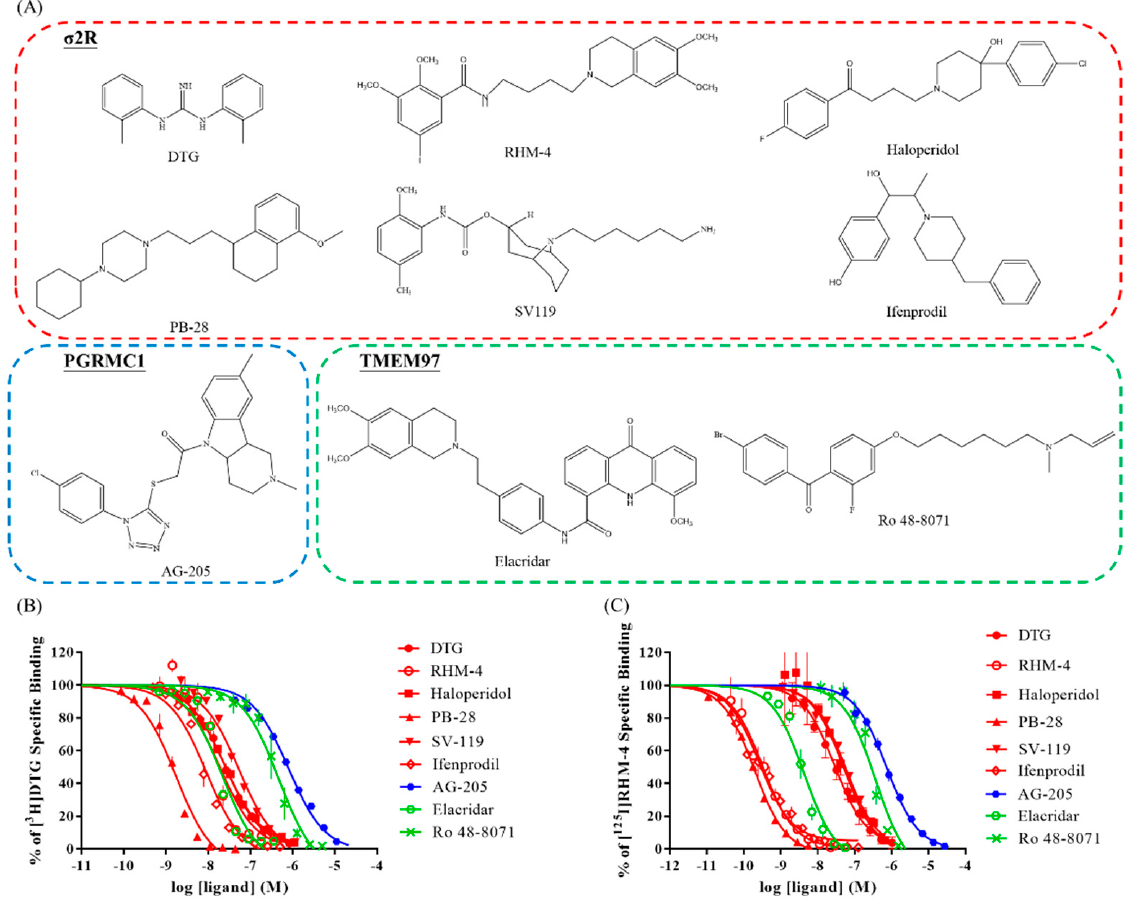
Figure 2. In vitro competition binding curves of different nonradioactive ligands. ( A ) The dif- ferent cold ligand structures used in this assay. The competition curves with [ 3 H]DTG ( B ) and [ 125 I]RHM-4 ( C